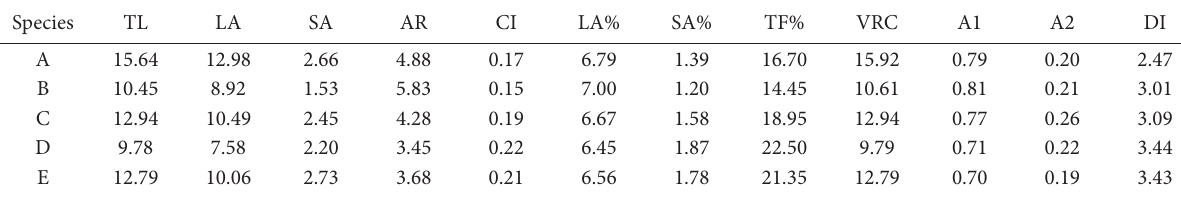
Table 2. Mean of parameters of chromosomes analysis of L. lancifolium and four related cultivars. Species